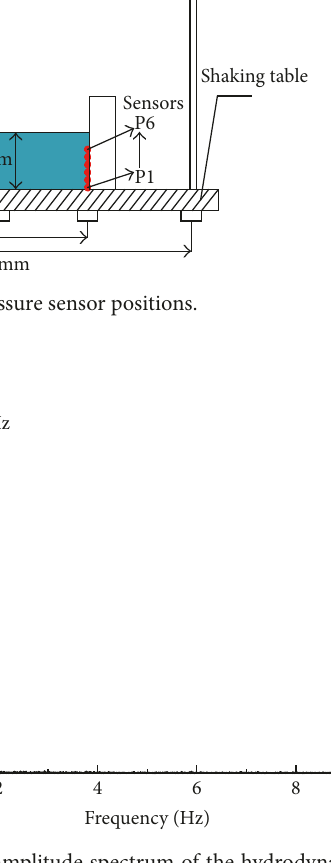
Figure 3: Fourier amplitude spectrum of the hydrodynamic pres- sure of the reservoir employed in the tests due to white noise